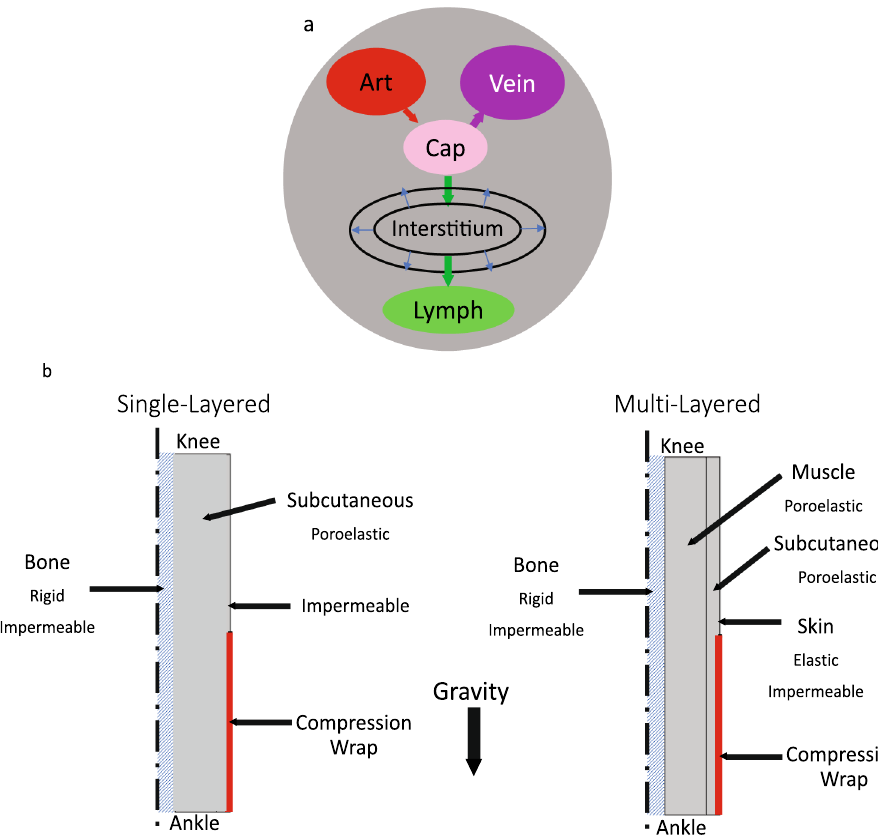
Figure 1. Conceptual model and geometry. ( a ) The local fluid exchange between the interstitium and the capillaries and initial lymphatic vessels is represented as a distributed source/sink without explicitly representing individual blood or lymph vessels. ( b ) Simplified, axisymmetric geometries of the lower leg used in the model. The bone is assumed to provide a rigid, impermeable surface at the inner boundary of the soft tissues. The soft tissue may move radially and vertically at the upper and outermost boundaries, but can move only radially at the lower boundary. Fluid can enter or leave the system locally via the blood and lymph vessels or through the interstitium at the upper boundary. All other boundaries are